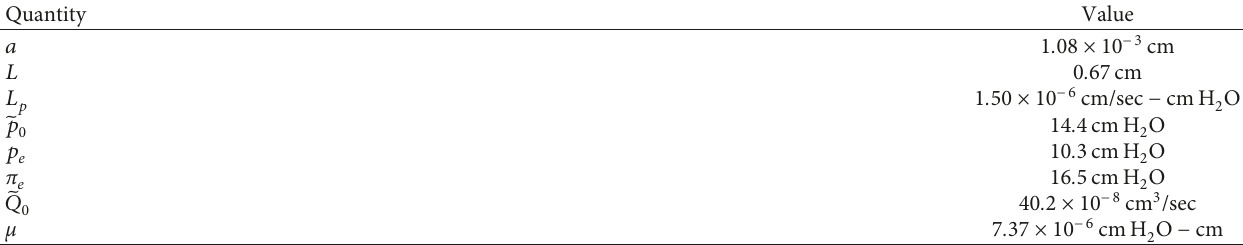
Table 1: Physiological data for the rat proximal convoluted tubule [6, 8].